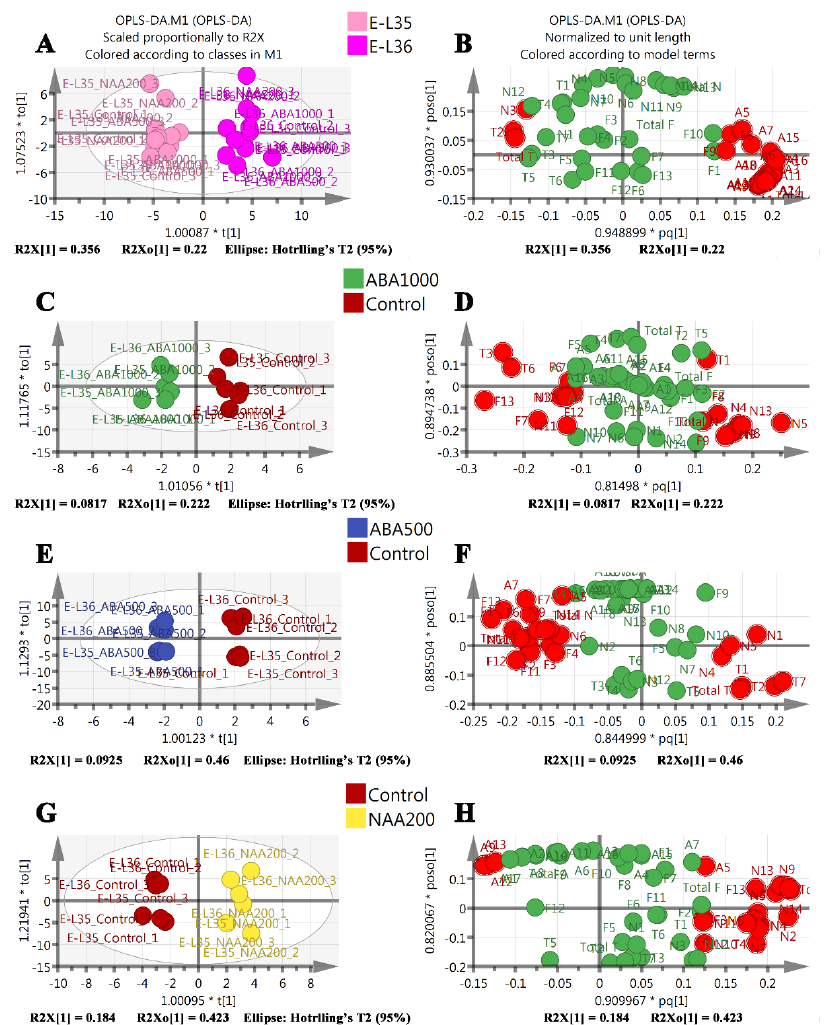
Figure 6. Supervised (developmental stage and treatments) orthogonal partial least squares-discriminant analysis (OPLS) of all metabolites from the stages of E-L 35 (ripening initiation) and E-L 36 (berries with intermediate Brix values). ( A ) Score plot of the respective samples, developmental stages are highlighted with different colors. ( C ) Score plot for the respective samples, ABA1000, and control group are highlighted with different colors. ( E ) Score plot for the respective samples, ABA500 and control group are highlighted with different colors. ( G ) Score plot for the respective samples, NAA200 and control group are highlighted with different colors. ( B, D, F, H ) Loading plot for the measured variables in green. Red spots represent the variables significantly contributing to the models with variable importance plot (VIP) values larger than 1.